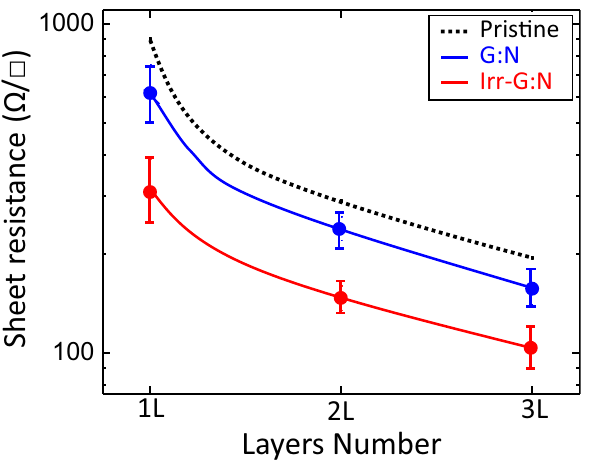
Figure 7. Sheet resistance data for nitrogen doped graphene multilayer before (G:N) and after Xe lamp irradiation (Irr-G:N). Dotted line (from Ref 13 ) is to guide eyes to read sheet resistance of pristine graphene without nitrogen